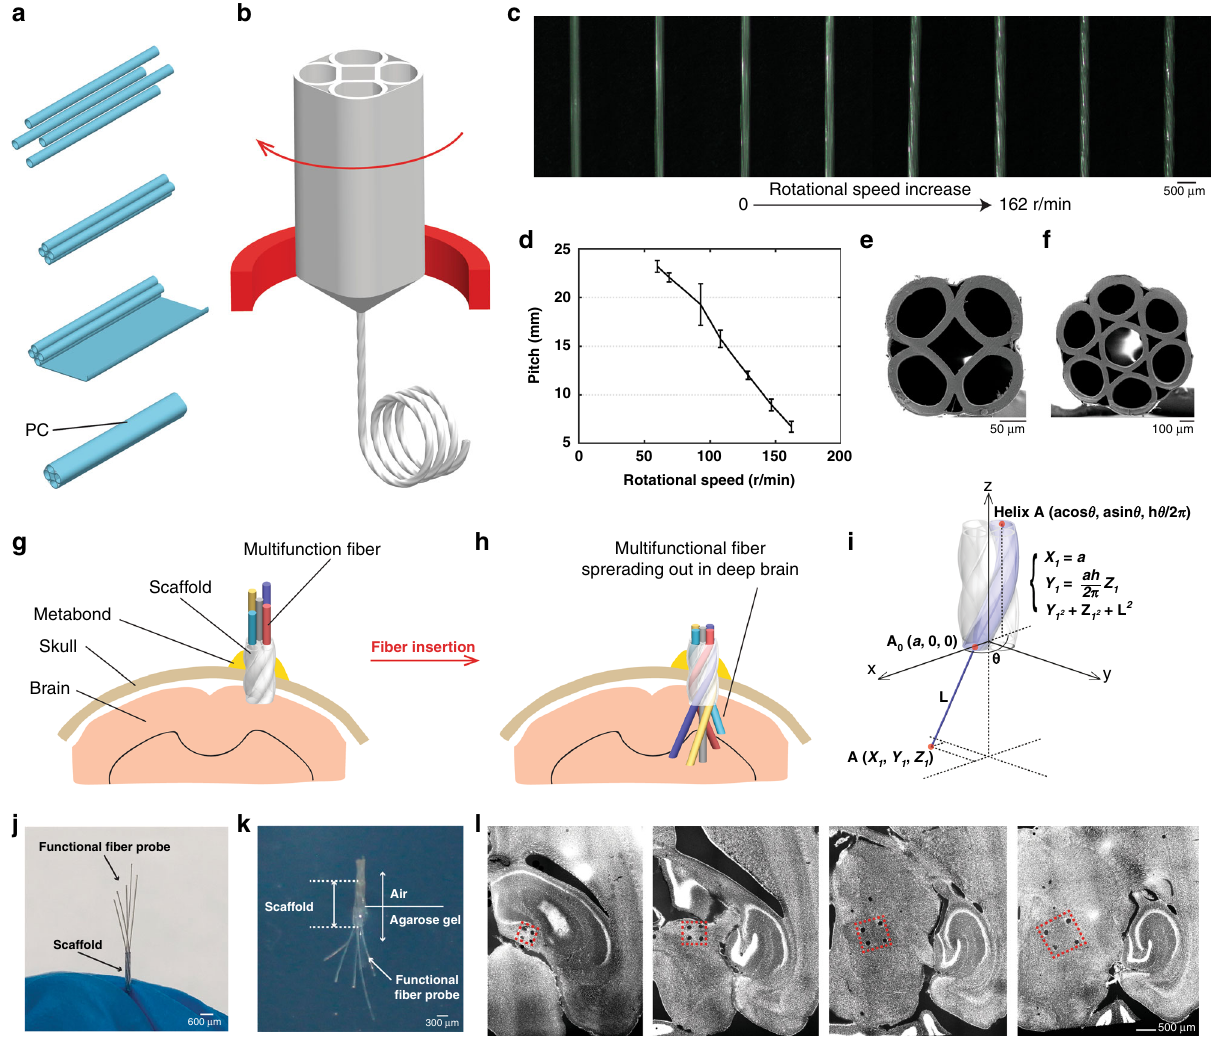
Fig. 2 Spatially expandable multifunctional fi ber-based probes. a Scaffolding fi ber preform fabrication process. b Fiber drawing process with customized rotational feeding stage. c Side-view optical images of the scaffolding fi bers drawn at different rotational speeds. d Plot showing the relatively linear relationship between the pitch and the rotational speed utilized in this study. e , f SEM images of the scaffolding fi bers with fi ve and seven hollow channels. g – i Schematics of the employment of the spatially expandable functional fi ber probes: g scaffolding fi ber is inserted into the brain and af fi xed by Metabond ® ; h functional fi ber probes are further inserted into the brain tissue through the scaffolding fi ber; i mathematical model of the locations of the inserted fi ber probes. j Pre-validation of the expansion of the inserted functional fi ber probes before implant surgeries. k Validation of the expandable fi ber probes in the brain phantom. l Transverse DAPI-stained brain slices from the mouse with the spatially expandable fi ber probes implanted for one week ( n = 10). Representative images are shown taken from 10 animals. All error bars in the fi gure represent the standard